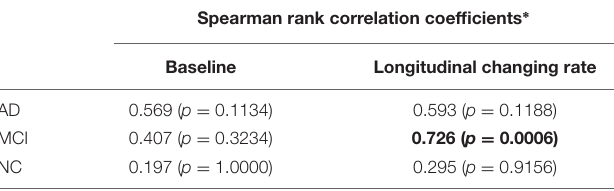
TABLE 4 | Correlation between the baseline GMV and cortical thickness decline indicators (left column), and their longitudinal changing rate (right column) for AD, MCI, and NC